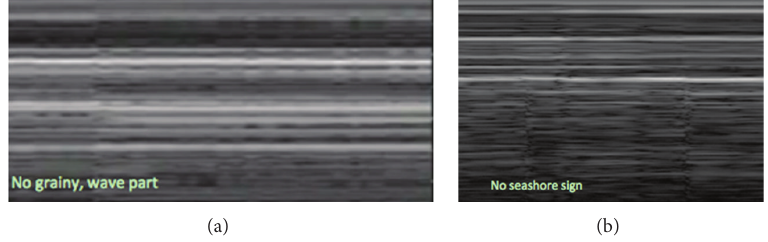
Figure 1: Pneumothorax diagnosed using ultrasound.